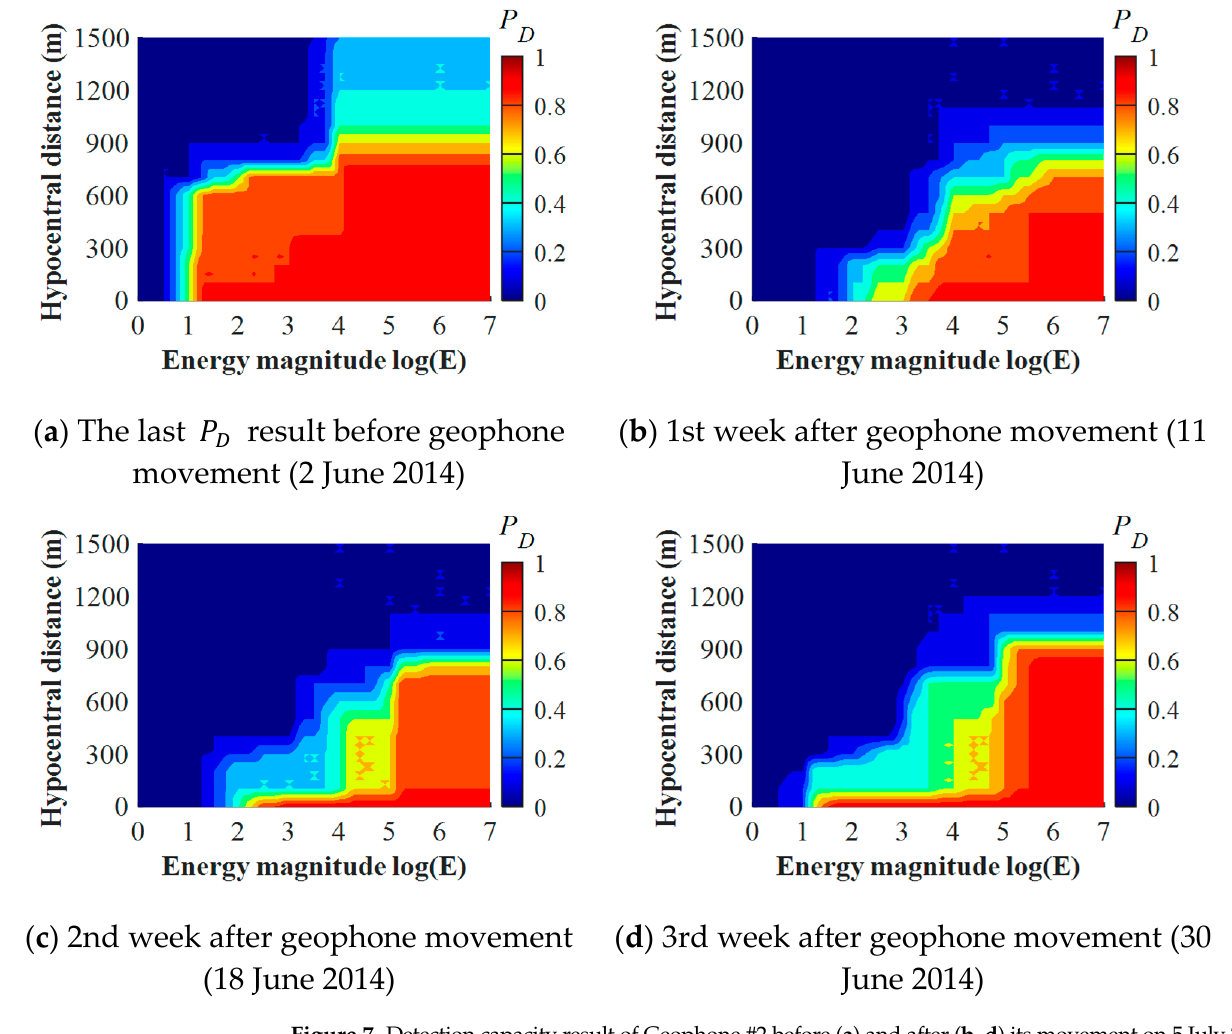
Figure 7. Detection capacity result of Geophone #2 before ( a ) and after ( b – d ) its movement on 5 July 2014 in LW250105.